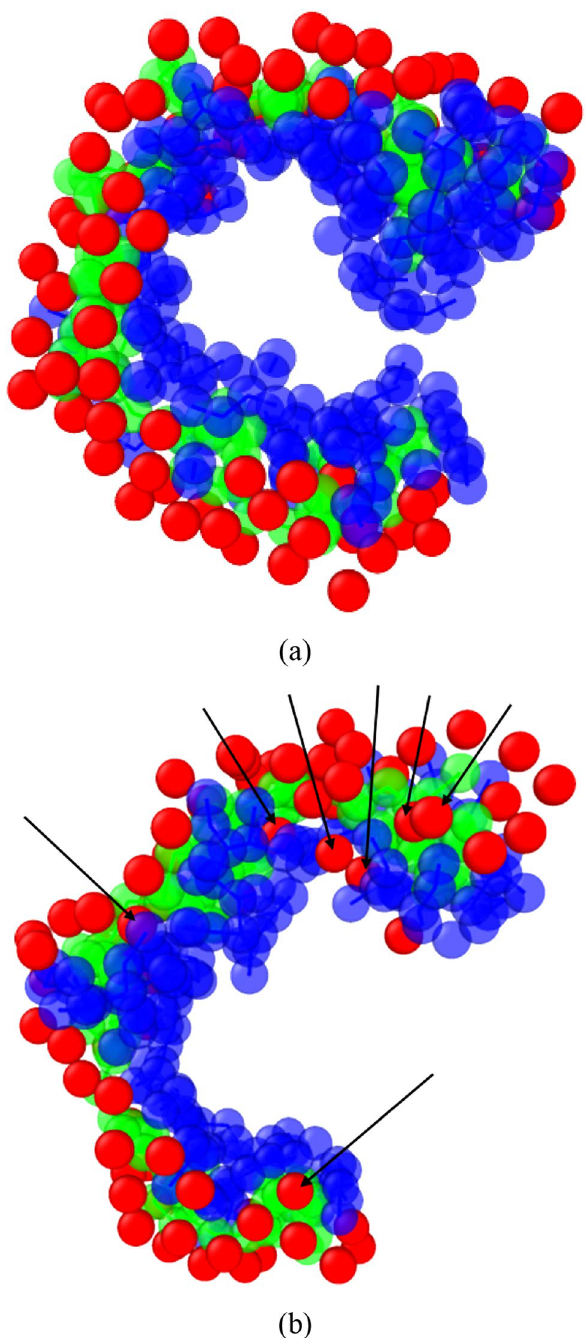
Figure 5. The water bead distribution within 7 Å from Apt EpA for ( a ) CG_AA and ( b ) CG_Case1. The arrows indicate the water beads located at the interface between Apt EpA and EpCAM. The Apt EpA , EpCAM, and water beads are marked in green, dark blue, and red, respectively. For clarity, the rest water beads, antifreeze beads, and Na + beads are